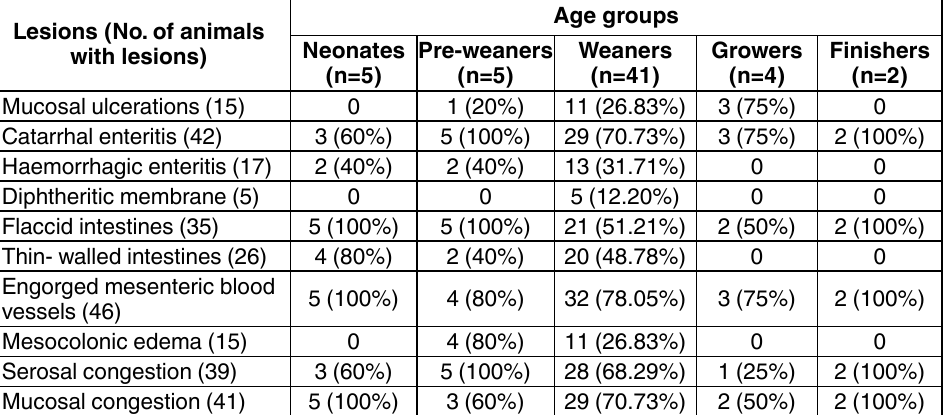
table 3. Age-wise occurrence of gross changes in intestines lesions (No. of animals with